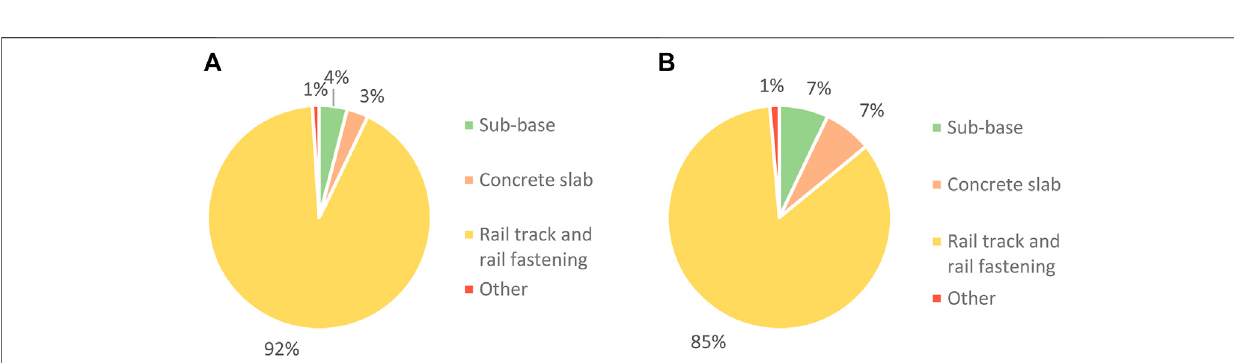
FIGURE 11 | Energy consumption for off-street (A) and street (B)